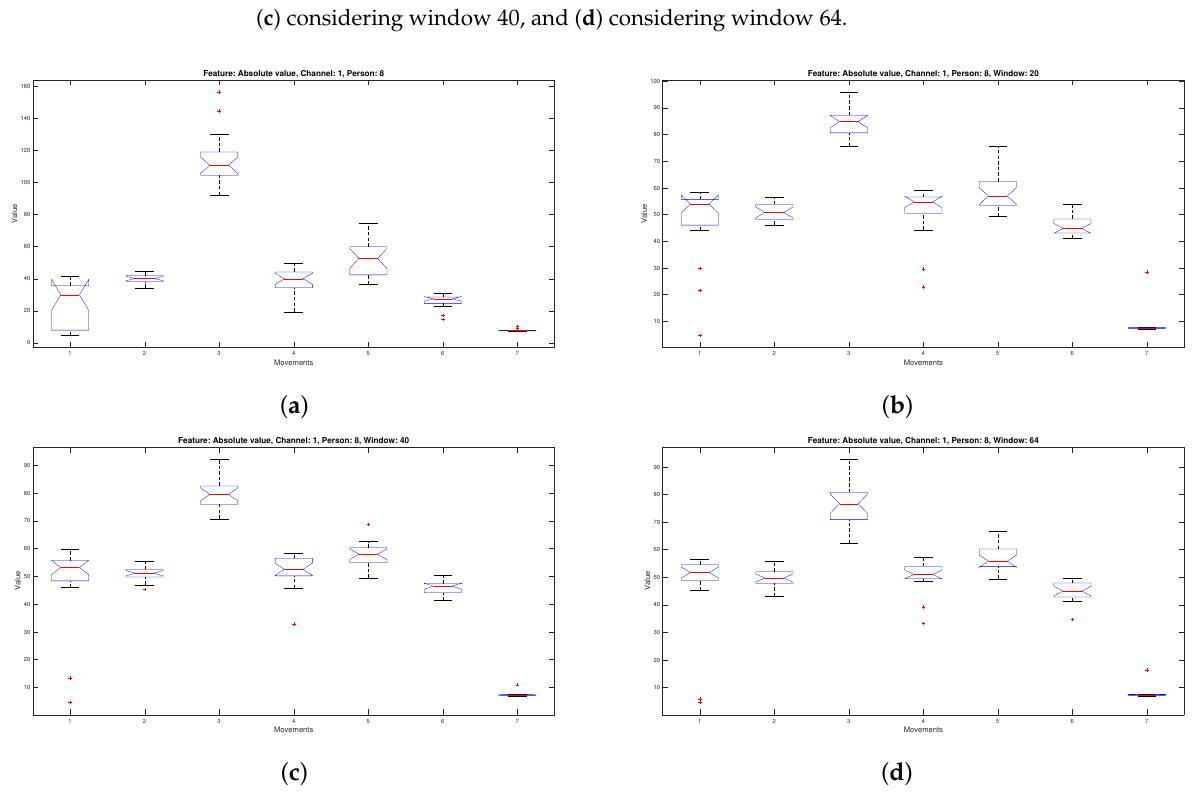
Figure 9. Box plot of absolute value characteristic corresponding to the seven movements of channel one of person eight ( a ) considering the unsegmented signal, ( b ) considering window 20, ( c ) considering window 40, ( d ) considering window